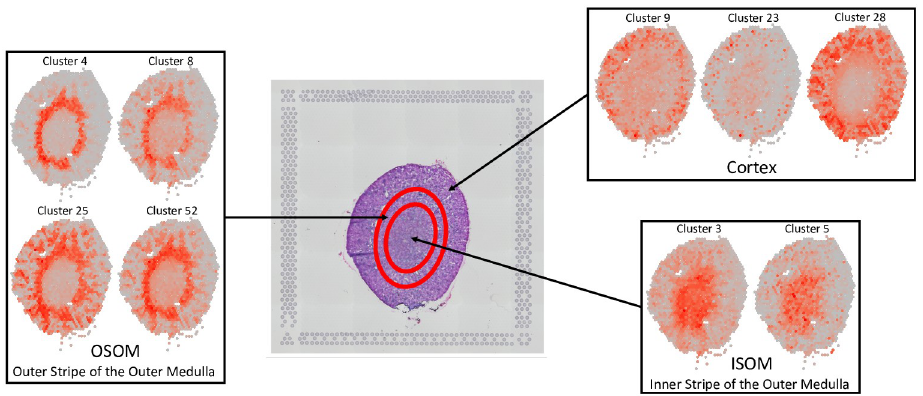
Fig 7. FIST recovers spatial gene expression patterns on Mouse Kidney Section. The H&E image of the mouse kidnesy section is shown in the middle with circles roughly separating the tissue area of Cortex, the outer stripe of the outer medulla (OSOM) and the inner stripe of the outer medulla (ISOM) from outer to inner regions. The gene expression patterns of the clusters in each of the three regions are grouped in the same box labeled by the